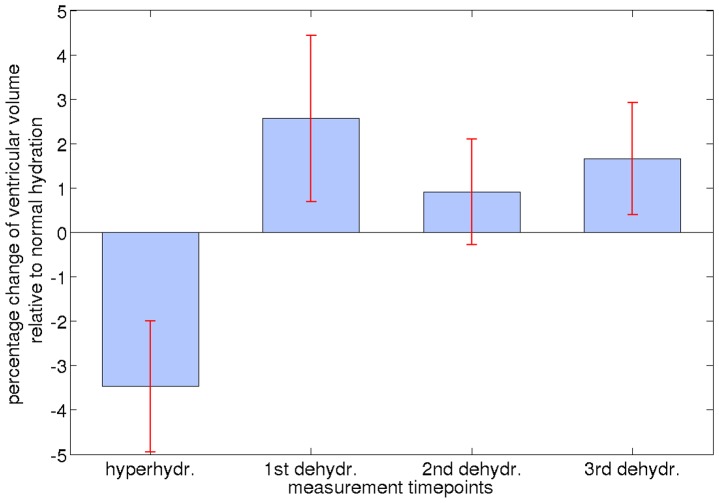
Ventricular volume change, obtained using FreeSurfer segmentation results, in percent in comparison to normal hydration (set to 100%).Red lines indicate standard error.